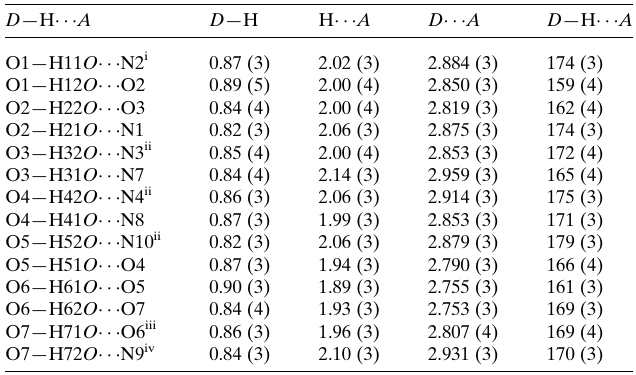
Table 1 Hydrogen-bond geometry (A˚ , (cid:3)